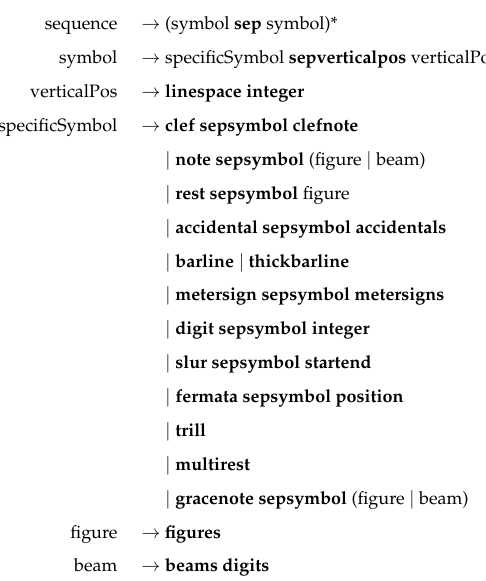
Table A4. Agnostic file